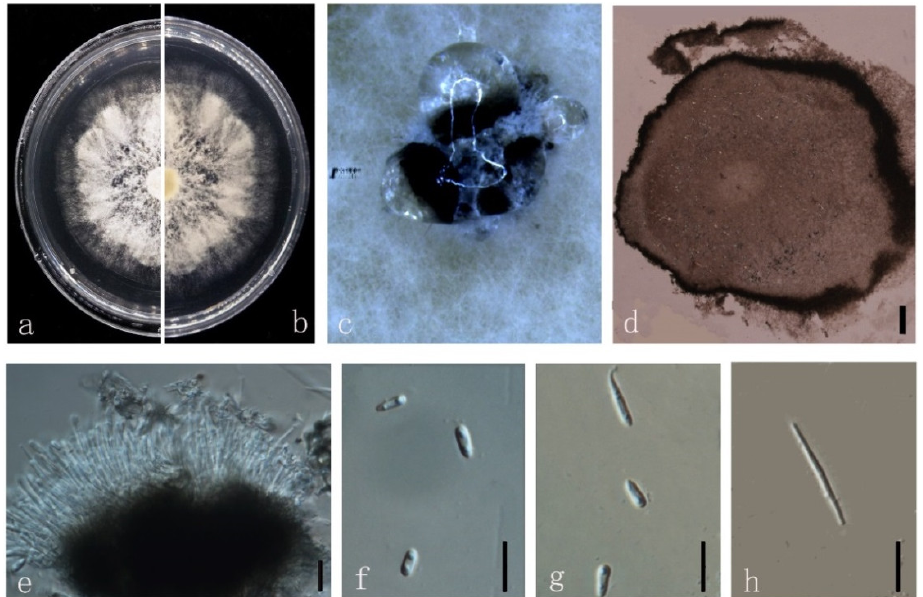
Figure 7. Diaporthe heliconiae (ZHKUCC 22-0047) ( a ) upper view of colonies on PDA; ( b ) Reverse view of colonies on PDA; ( c ) Pycnidia with conidial droplets on PDA; ( d ) vertical section of pycnidia; ( e